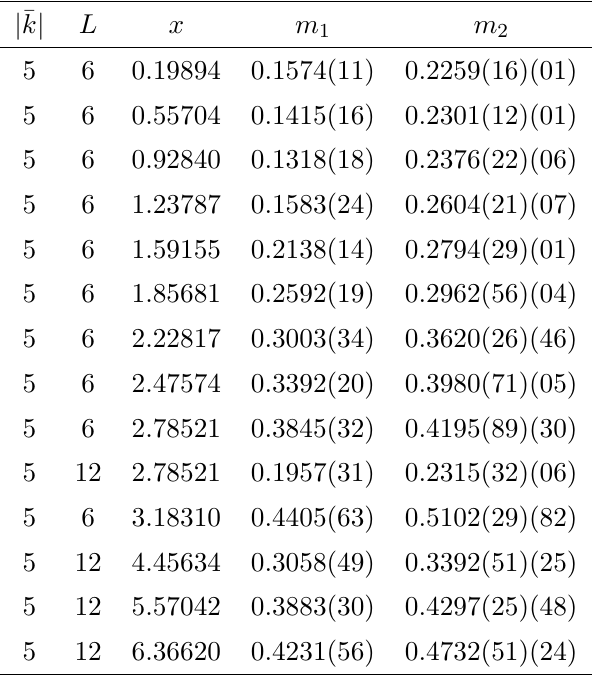
Table 24. Mass gap and next excited state energy (in lattice units) in the zero-electric (cid:13)ux scalar sector for SU(13).